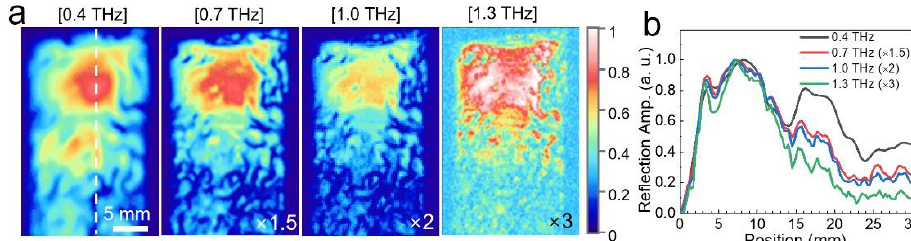
Figure 3. ( a ) A series of C-scan images corresponding to the frequencies of 0.4, 0.7, 1.0, and 1.3 THz. Because the signal strength decreased toward the high-frequency region, the THz amplitude signal was magnified for clarity for the high-frequency images. ( b ) THz amplitudes as a function of position along the vertical dashed line in ( a ) for the different frequencies.